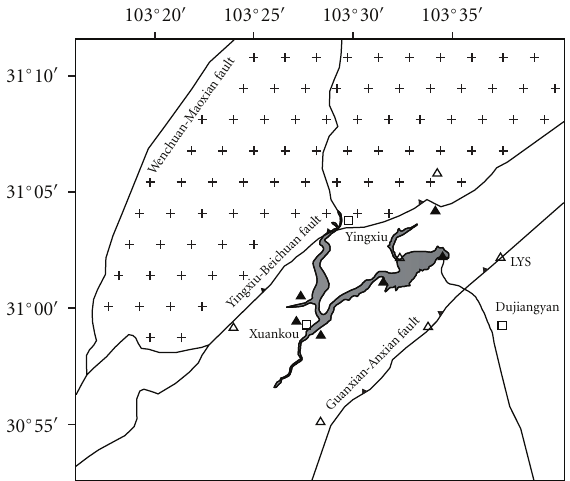
Figure 1: Geological sketch map of the study area. The areas filled with plus symbols are igneous rocks of the Pengguan massif,and the other areas are sedimentary rocks. Black open triangles are seismic stations of the Zipingpu reservoir network. Black closed triangles are the temporary seismic stations. Bold lines denote the faults. Fine lines denote the river. Gray region represents the Zipingpu reservoir. Squares represent the county. LYS represents the name of the station.